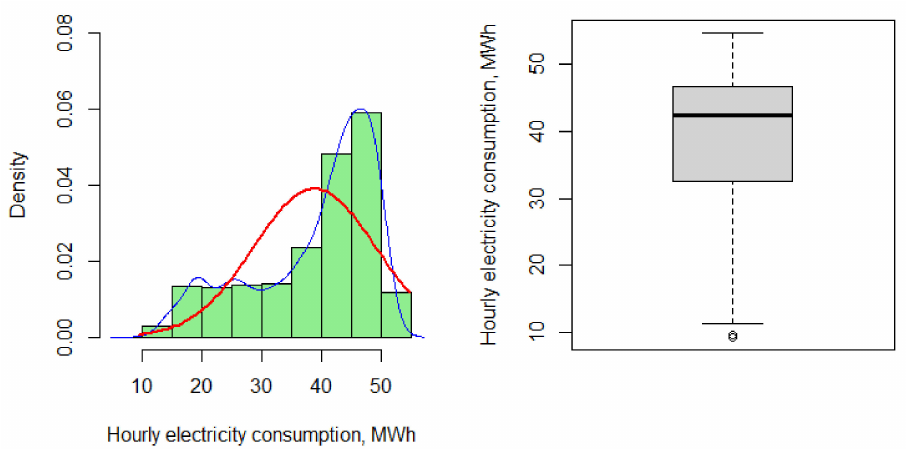
Figure 11. Graphical representation of the distribution of hourly electricity consumption for the M4 object. Source: own study in the RStudio environment.